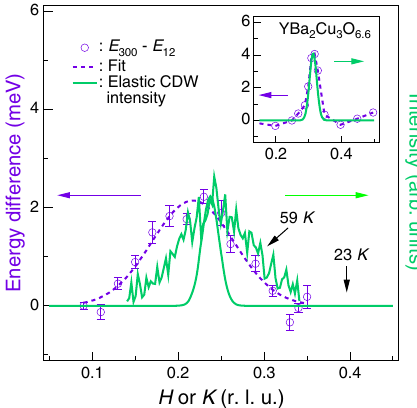
FIG. 4. Comparison between phonon softening and diffraction. Purple circles plot CDW-related phonon softening. The main panel plots the energy difference between 300 and 12 K for La 1 Ba 0 CuO 4 , whereas the inset shows the softening . 875 . 125 between 300 and 5 K for YBa 2 Cu 3 O 6 þ δ . Dashed purple lines are guides to the eye. These are compared to diffraction data in green. For YBa 2 Cu 3 O 6 þ δ [11], the phonon softening mirrors the CDW Bragg peak. In La 1 Ba 0 CuO 4 , the phonon softening . 875 . 125 does not match the ordered CDW Bragg peak taken at 23 K; rather, it matches precursor CDW measured at 59 K [24].